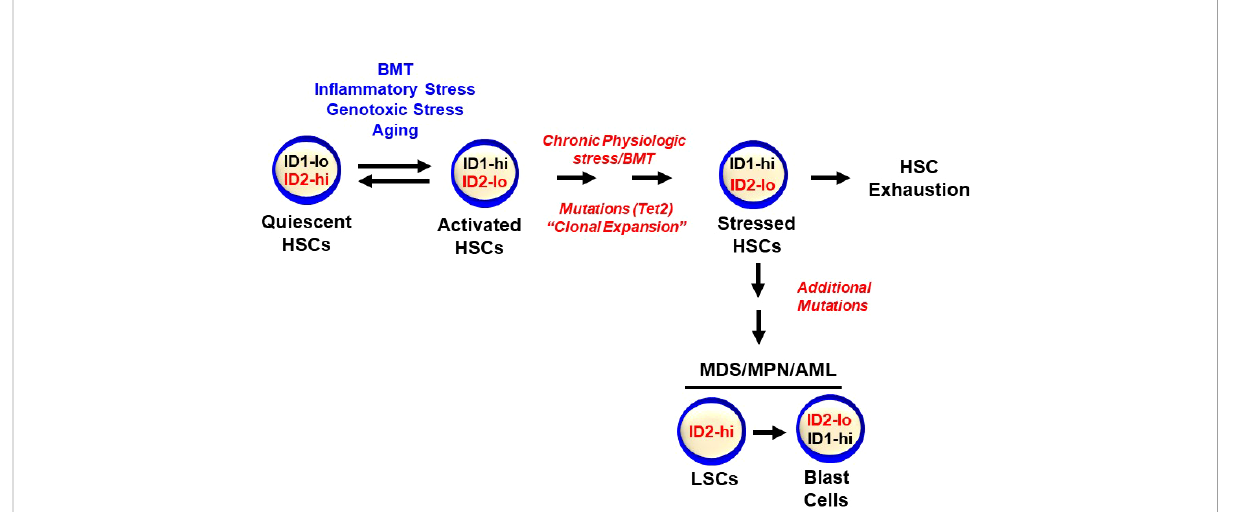
FIGURE 3 Id1 and Id2 are differentially expressed during HSC activation and quiescence. HSCs express low levels of Id1 that are induced during stress including BMT, genotoxic and in fl ammatory stress, and aging. Id2 is required to maintain HSC quiescence and Id2 decreases during HSC proliferation and activation, after which, Id1 levels decrease and Id2 levels increase as HSCs return to quiescence. Chronic stress can lead to HSC exhaustion and clonal hematopoiesis and hematopoietic